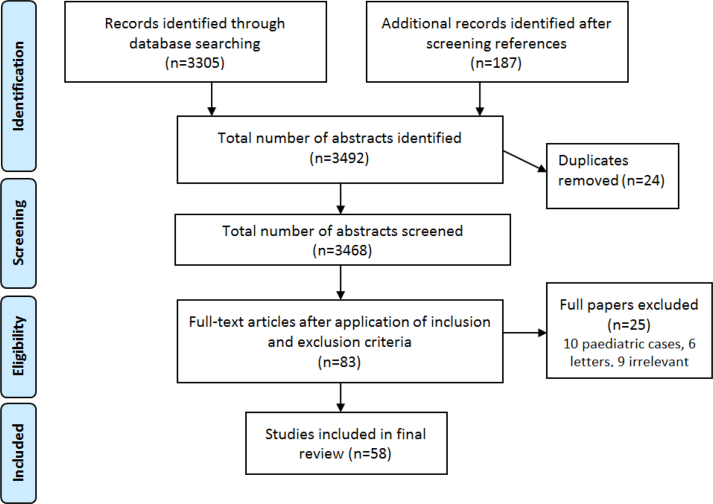
PRISMA flow diagram.